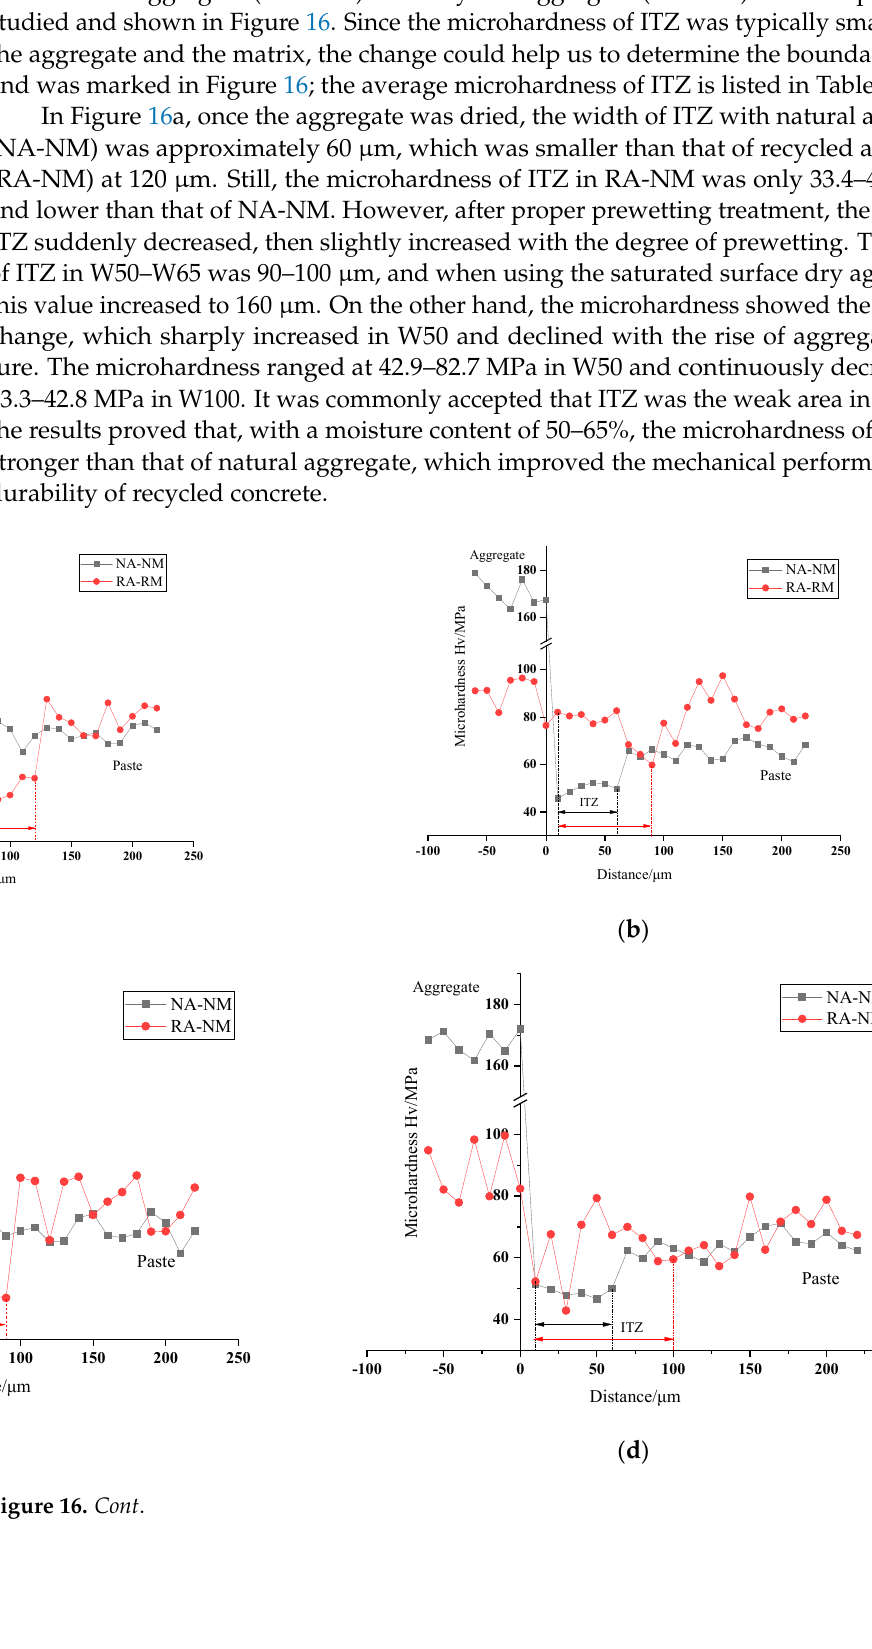
Table 4. The variation range of 28 d microhardness in the interfacial transition zone of recycled concrete.